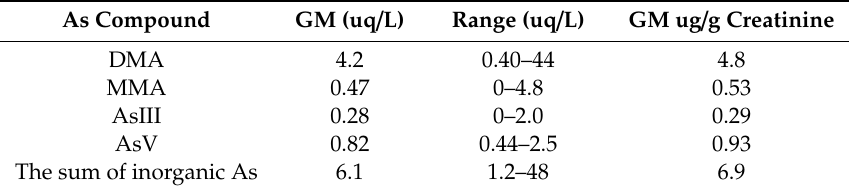
Table 4. Geometric mean values for inorganic arsenic (As) with metabolites in urine unadjusted and adjusted for creatinine.